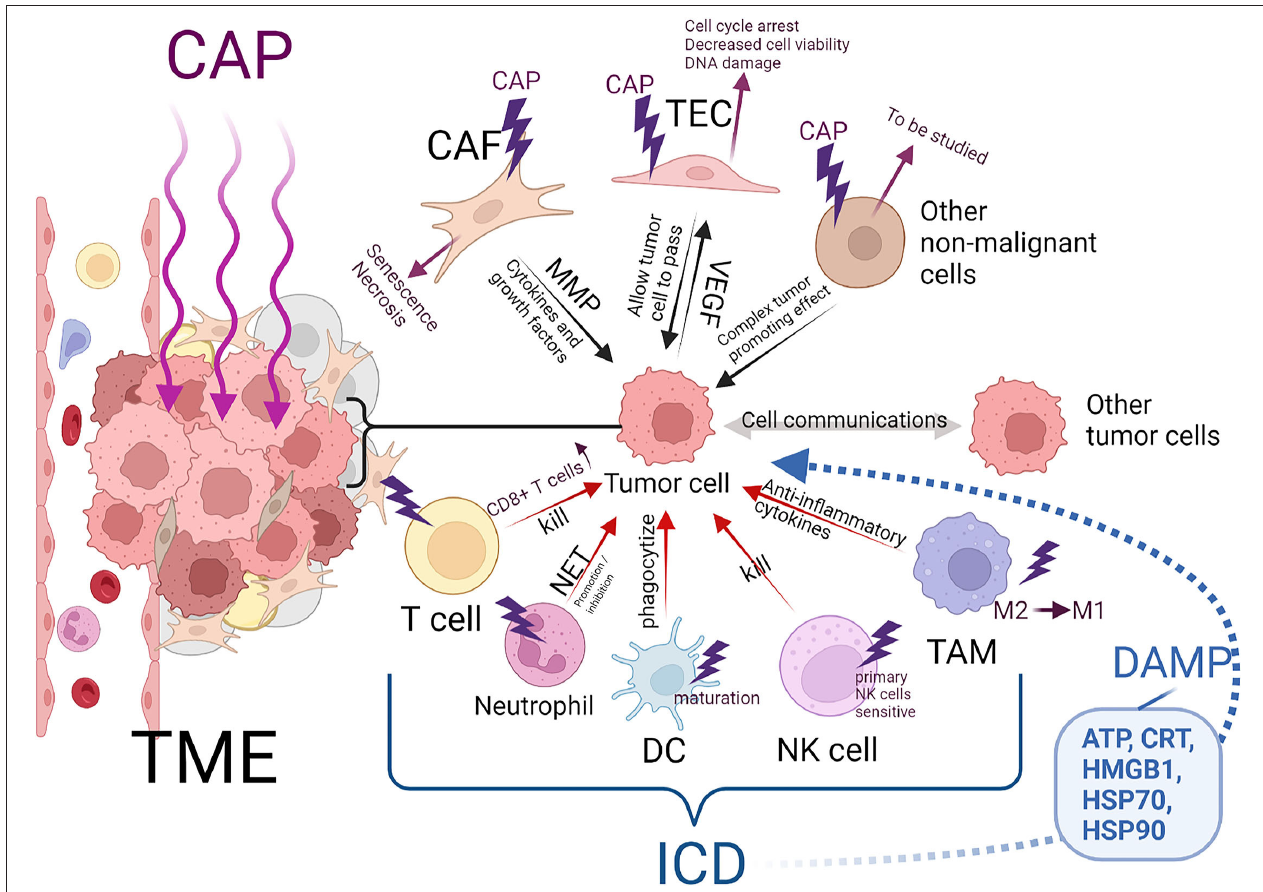
FIGURE 3 | Effects of CAP on non-malignant cells in solid tumor microenvironment and induce immune death of tumor cells. Created by